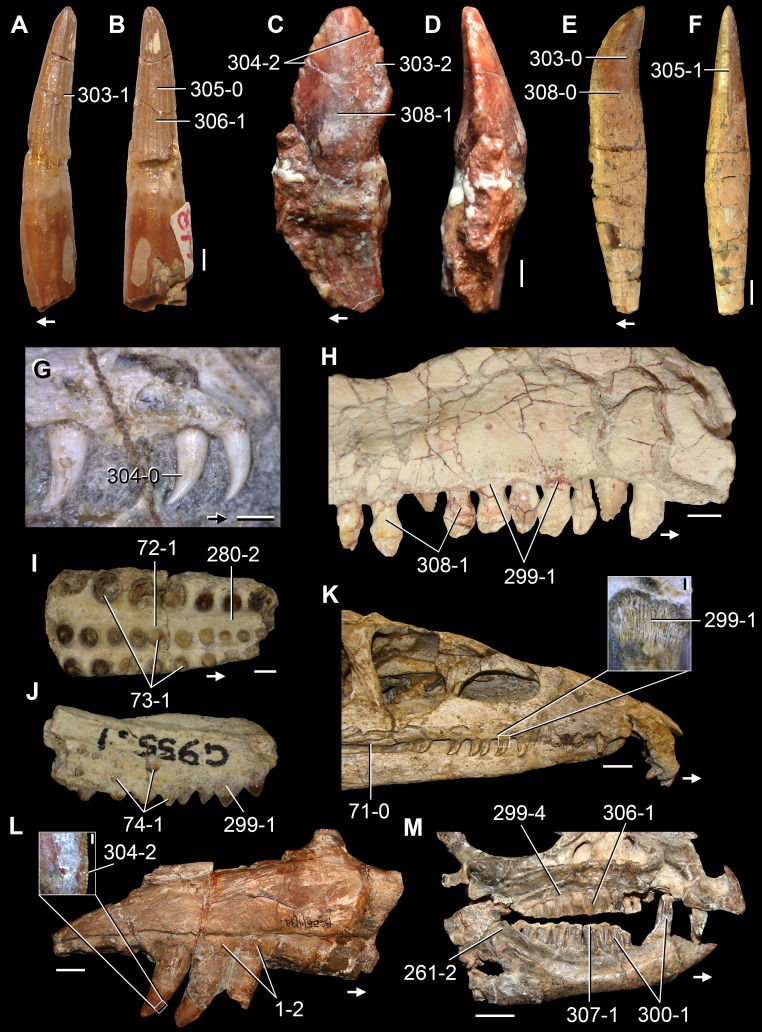
Teeth and tooth implantation in Triassic and Early Jurassic archosauromorphs in (A, C, E, G, H, K, M) labial, (B, D, F) mesial, (I) occlusal, and (J, L) lingual views.Isolated teeth of (A, B) Tanystropheus longobardicus (SMNS 54147), (C, D) Azendohsaurus laaroussi (MNHN-ALM 424) and (E, F) Chalishevia cothurnata (PIN 4366/8), and (G) teeth in situ of Prolacerta broomi (BP/1/4504a), (H) Azendohsaurus madagaskarensis (UA 8-29-97-160), (I, J) indeterminate rhynchosaurid from the Middle Triassic of England (WARMS G955), (K) Proterosuchus fergusi (BSPG 1934-VIII-514, mirrored), (L) Erythrosuchus africanus (BP/1/2529, mirrored) and (M) Heterodontosaurus tucki (SAM-PK-K1332). Close-ups of ankylothecodont tooth implantation in (K) and mesial denticles in (L). Numbers indicate character-states scored in the data matrix and the arrows indicate anterior direction. Scale bars equal 2 mm in (A, B, I, J), 1 mm in (C, D, G), close-up of (K), close-up of (L), 5 mm in (E, F, H), 2 cm in (K, L), and 1 cm in (M).